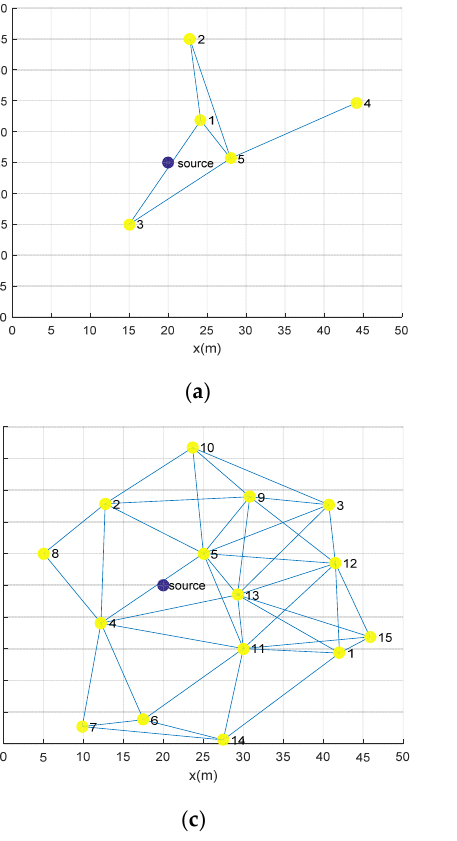
Figure 4. Signal of clean bird vocalization.